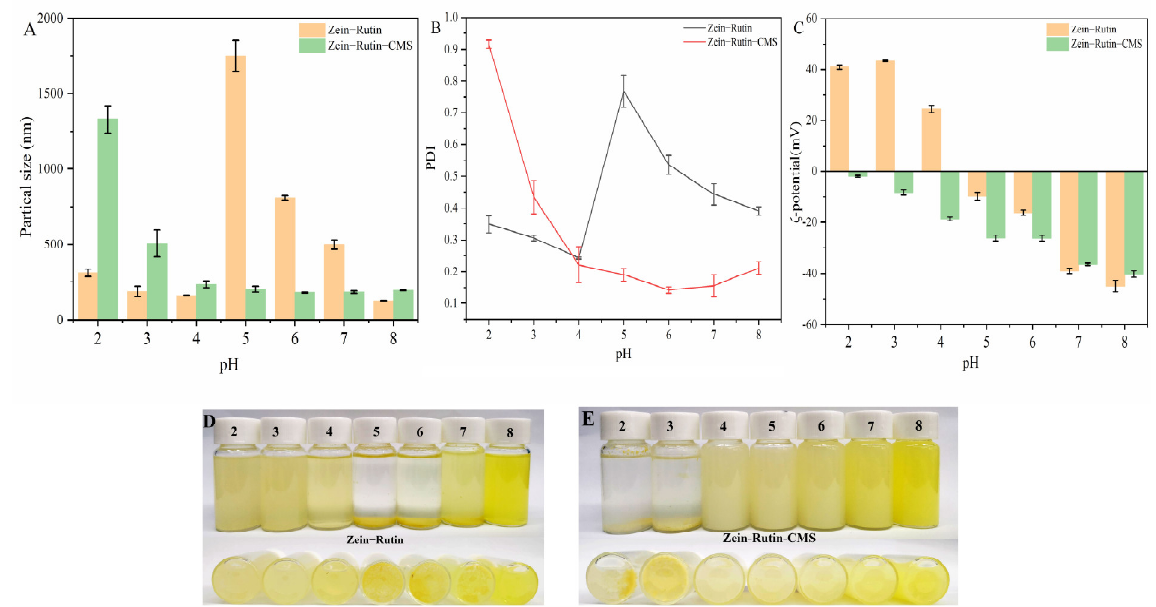
Figure 9. ( A ) Particle size of zein–RT and zein–RT–CMS nanoparticles; ( B ) PDI of zein–RT and zein–RT–CMS nanoparticles; ( C ) ζ–potential of zein–RT and zein–RT–CMS nanoparticles; ( D ) The